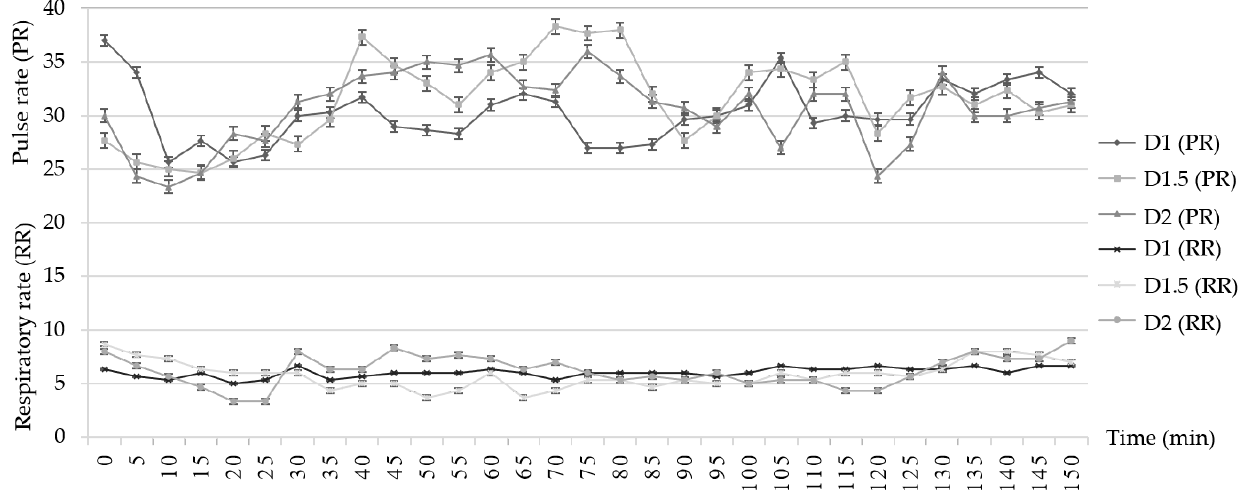
Figure 4. Line charts comparing the average pulse rate and respiratory rate between groups D1, D1.5 and D2 at various time points .